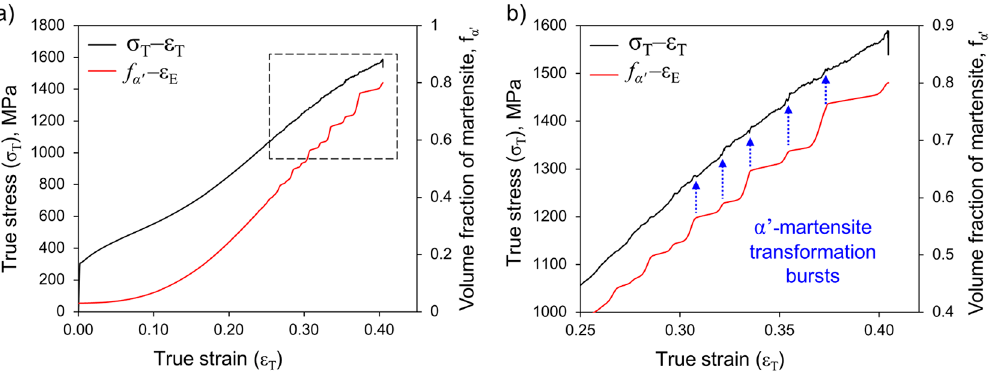
Figure 9. ( a ) True stress–strain ( σ T - ε T ) curve and evolution of f the sensor. ( b ) Magnification of the region marked with a square in ( a ) pointing out the effect of the transformation bursts on the strengthening of the material.